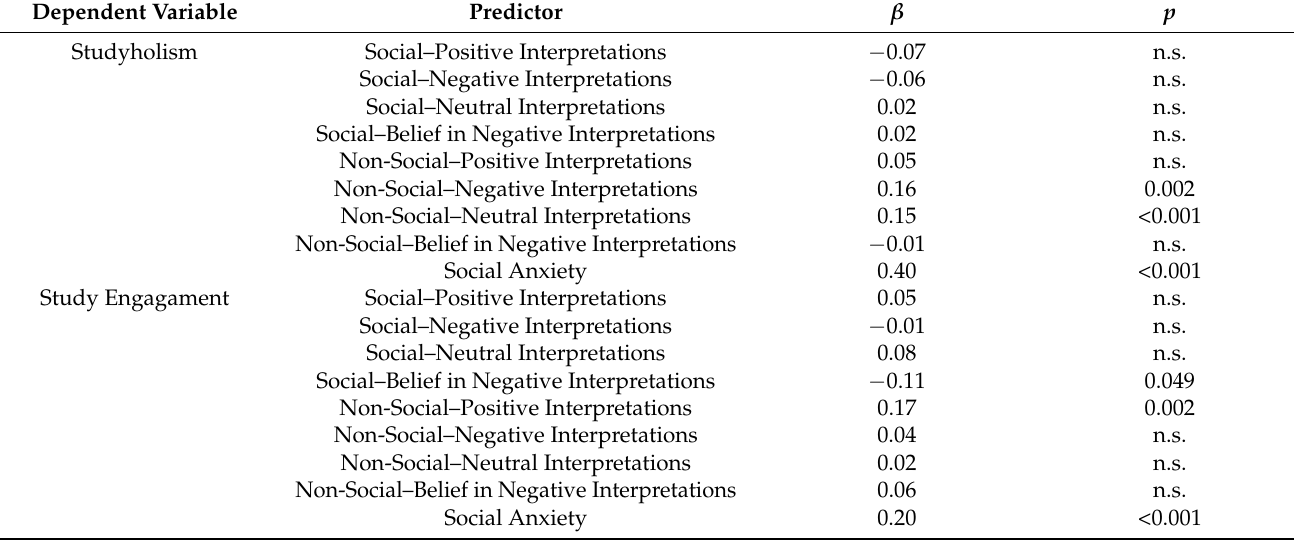
Table 3. Standardized path weights of the path analysis model ( n =